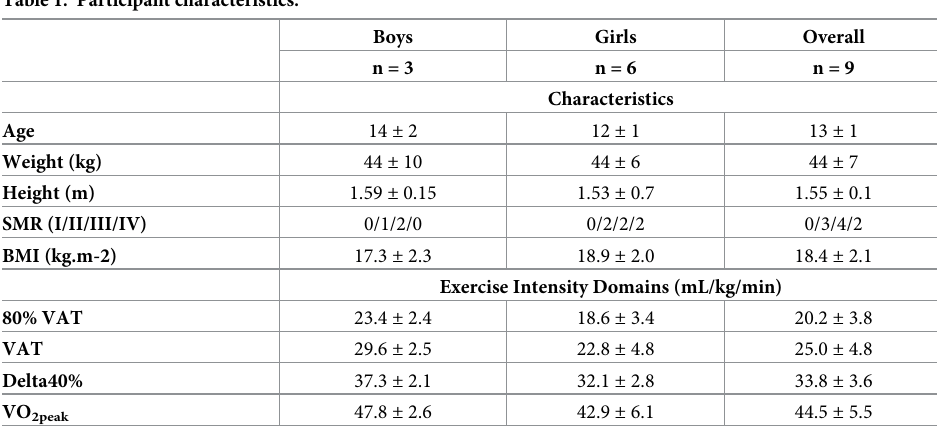
Table 1. Participant